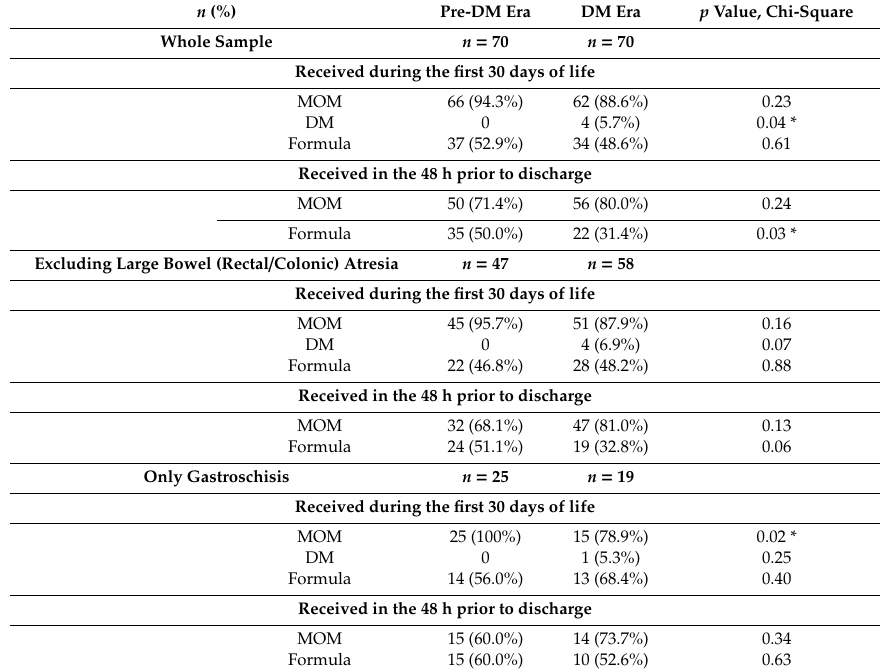
Table 2. Enteral feeding during hospitalization.